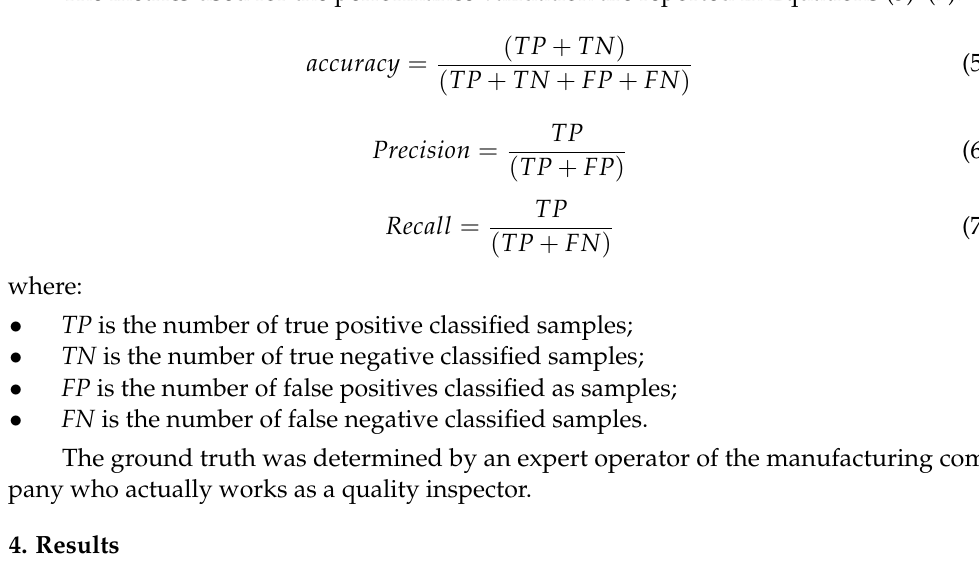
Table 2. Classification performances: standard algorithm.